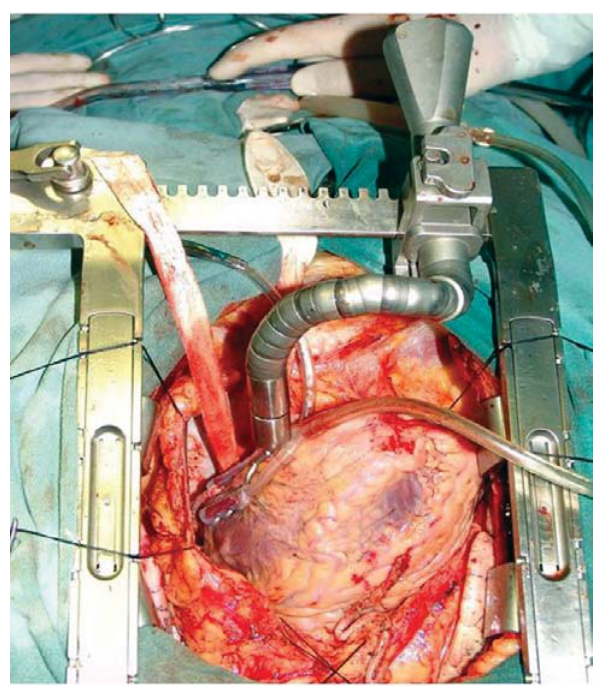
Fig 3 - Estabilizador por sucção